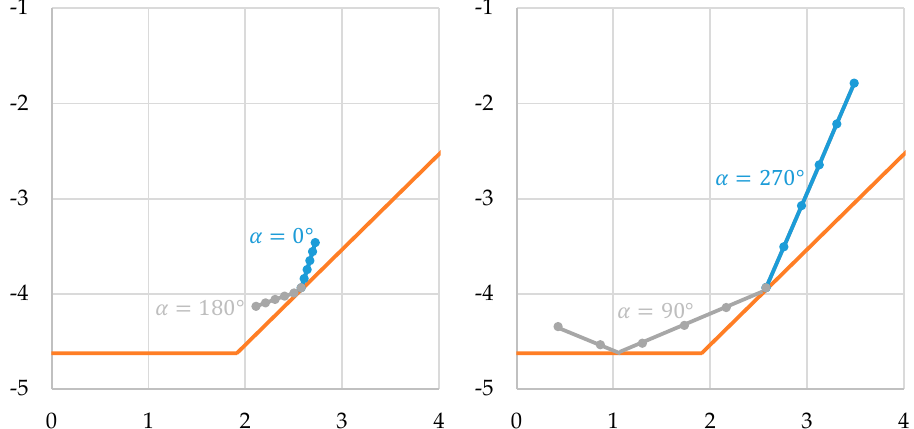
Figure 12. Position of the laser beam at the exit face in dependence of the bending angle (0 ≤ β ≤ 5 ◦ ) and bending orientation α . Dots for each full degree of β . Dimensions are in mm.